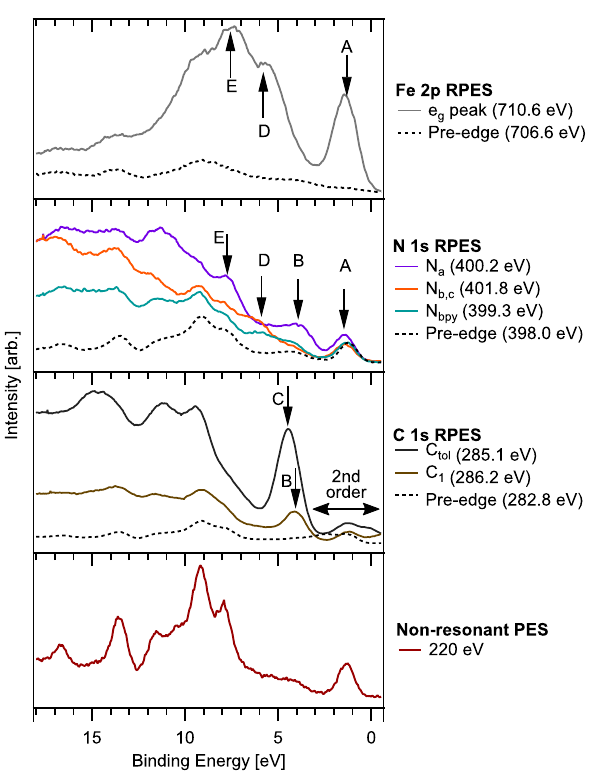
Figure 6. Valence band spectra of [ Fe II ( btz ) 2 ( bpy ) ] 2 + , extracted from the RPES maps in Fig. 5 at key resonant transitions. Also included are off-resonance valence band spectra measured in the pre-edge region (dashed lines) and at lower photon energy. The corresponding photon energy of each spectrum is indicated in the key. Features attributed to participant enhancement of frontier molecular orbitals are labelled A–E, and connect to the labelling of the representative molecular orbitals in Fig. 4. The contribution to the C 1 s RPES originating from direct C 1 s photoemission from 2nd order light is also